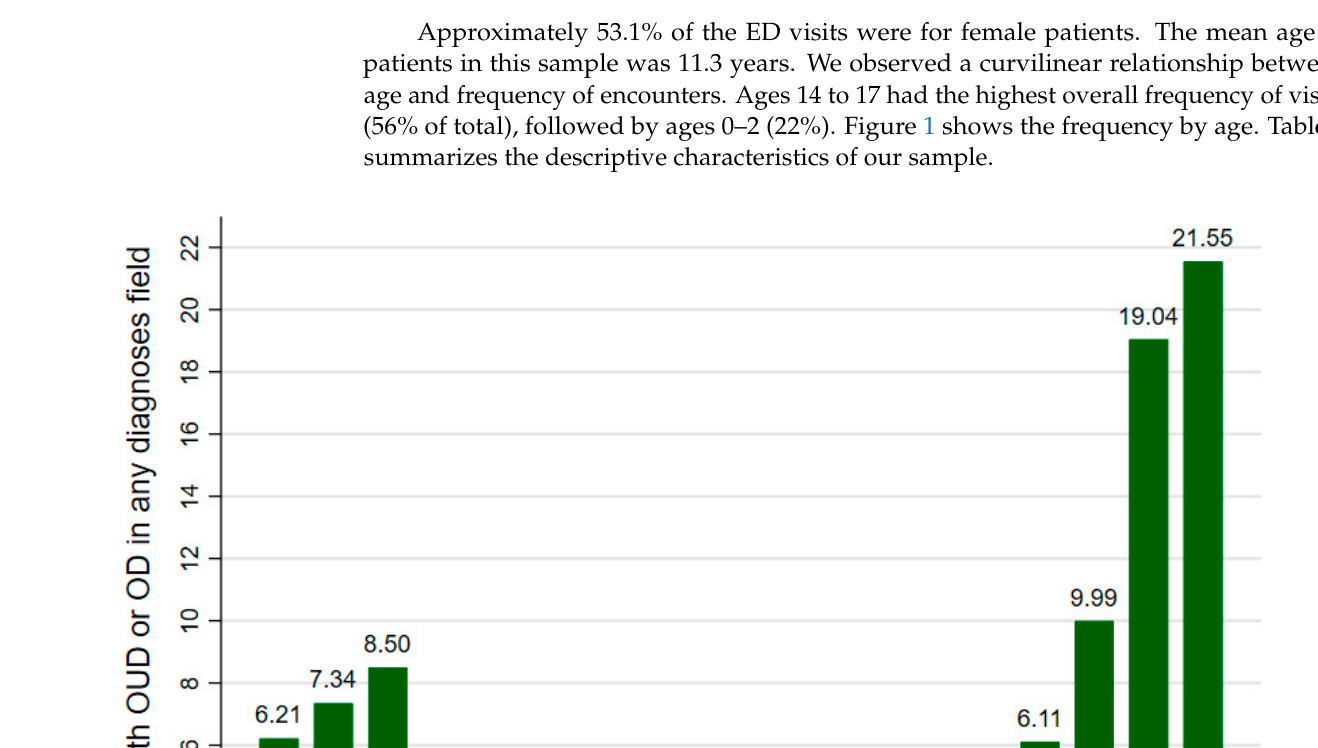
Table 1. Frequency of pediatric ED visits for opioid-related disorders (OUD) and opioid overdose